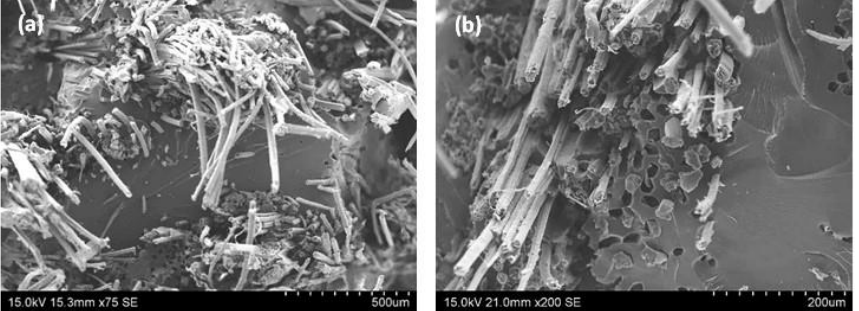
Figure 10. Scanning electron microscope images of fracture surface of unidirectional composites: ( a ) ×75; ( b ) ×200.